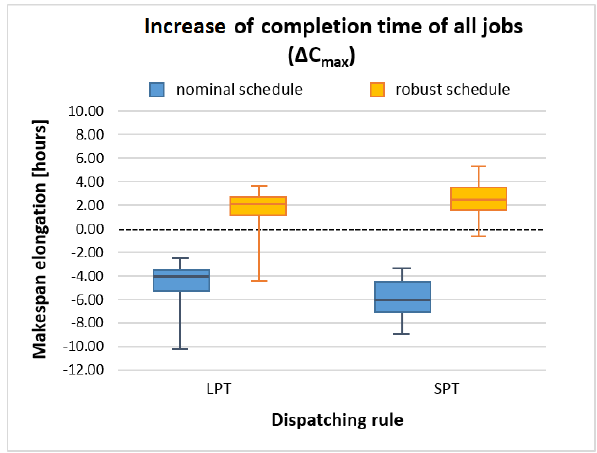
Figure 3. Increase of makespan in LPT and SPT schedules.